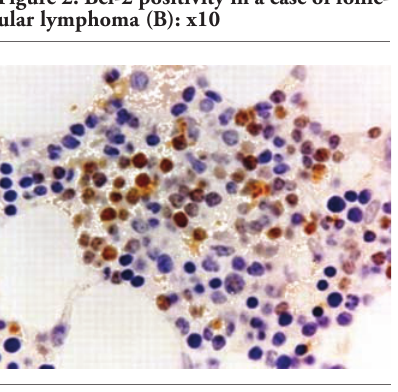
Figure 2. Bcl-2 positivity in a case of follic- ular lymphoma (B): x10